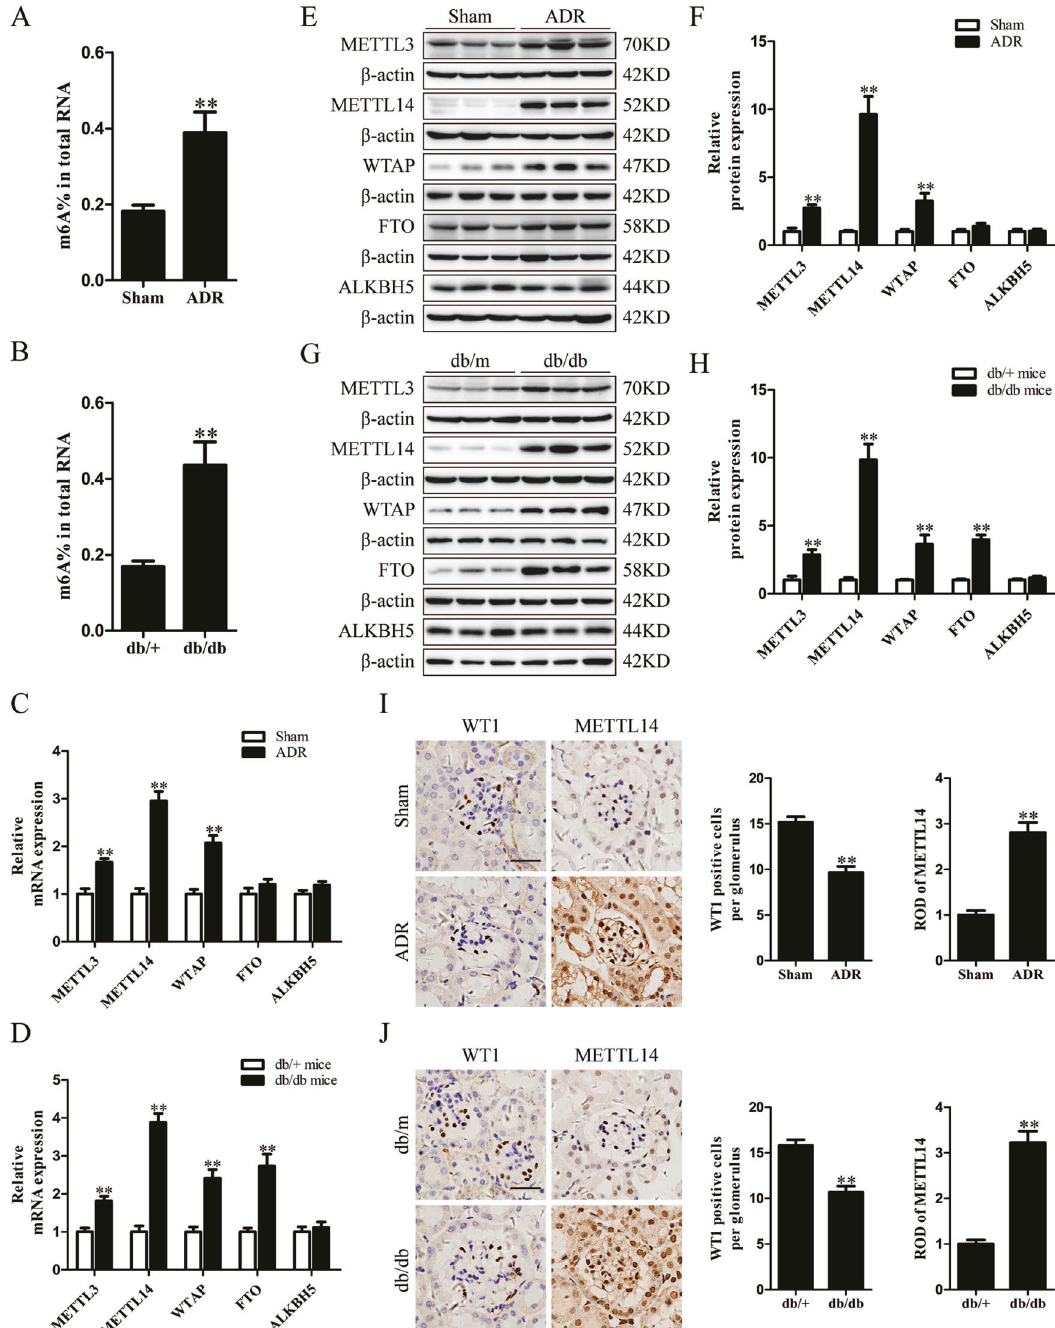
Fig. 1 METTL14-mediated RNA m6A modi fi cation were upregulated in the renal cortex of mice with ADR and diabetic nephropathy. A The m6A levels of total RNAs in the renal cortex from ADR-treated mice and their corresponding controls quanti fi ed by colorimetric ELISA assay ( n = 6). B The m6A contents of total RNAs in the renal cortex of diabetic db/db mice and control db/m mice ( n = 6). C The relative mRNA levels of major methyltransferases and demethyltransferases in the renal cortex of mice with ADR treatment or normal controls ( n = 6). D The relative mRNA levels of major m6A modifying enzymes in the renal cortex of db/db mice compared with control db/m mice ( n = 6). E , F Western blot analysis of major methyltransferases and demethyltransferases in the renal cortex of saline- or ADR-treated mice ( n = 6). G , H Western blot analysis of major m6A modifying enzymes in the renal cortex of db/db mice and control db/m mice ( n = 6). I Representative images and quanti fi cation of immunohistochemical staining for METTL14 and WT1 in kidney sections of mice with ADR treatment or normal controls. WT1 were used as podocyte marker. Scale bars, 20 μ m ( n = 6). J Images and quanti fi cation of immunohistochemical staining for METTL14 and WT1 in kidneys from db/m and db/db mice. Scale bars, 20 μ m ( n = 5). Data are presented as mean ± SEM. ** P < 0.01 vs. control